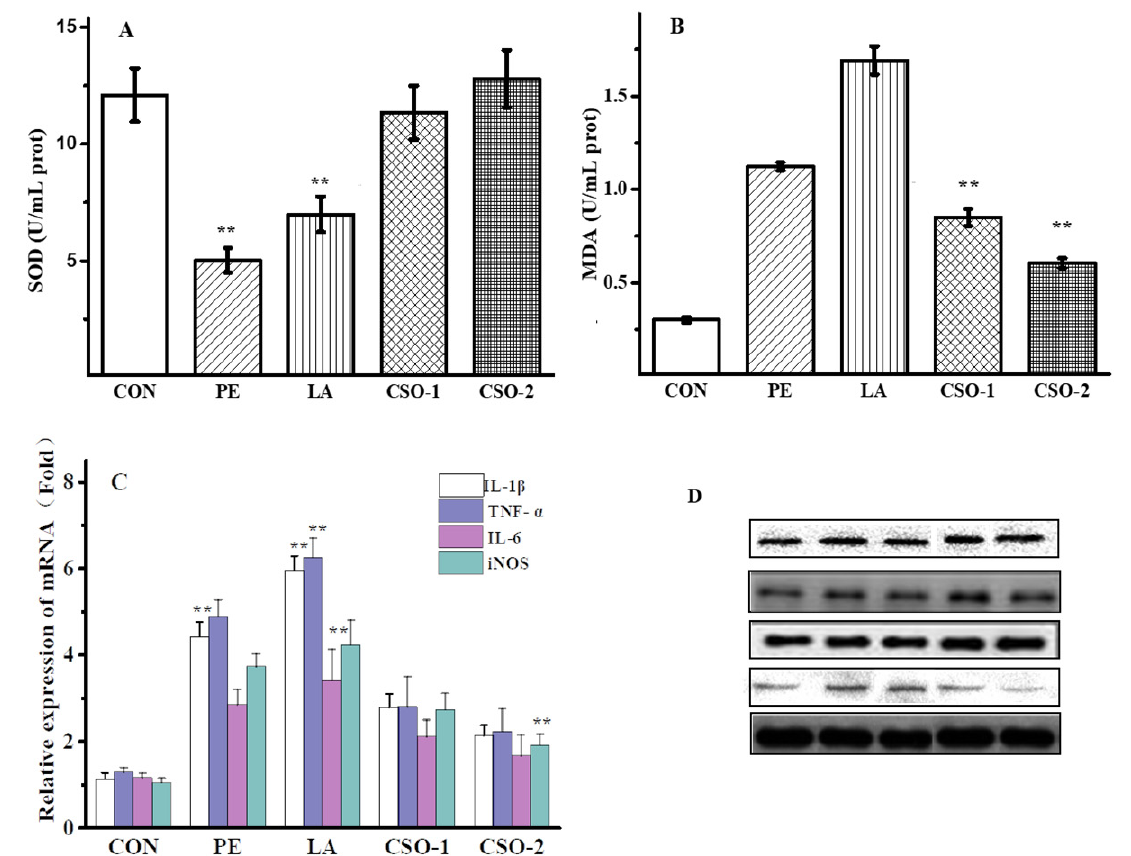
Figure 3. CSO inhibits the expression of oxidative stress and inflammatory factors in HFD-induced mouse liver tissue. ( A ) Effects of dietary fats on SOD level in the liver tissues of obesity mice; ( B ) Effects of CSO on MDA level in the liver tissues of obesity mice; ( C ) mRNA expression levels of cytokines were examined by RT-qPCR analysis ( n = 15); ( D ) Protein expression levels of IL-6, TNF- α , and INOS were detected by Western blotting analysis ( n = 3) (p < 0.01 (**) compared to the CON